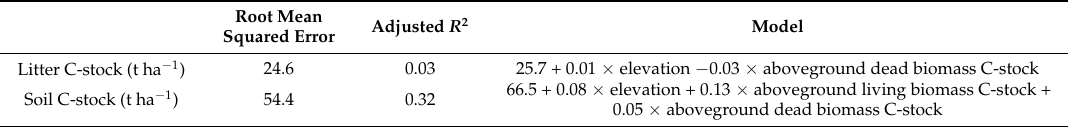
Table 6. Stepwise multiple regression results for litter C-stock and soil